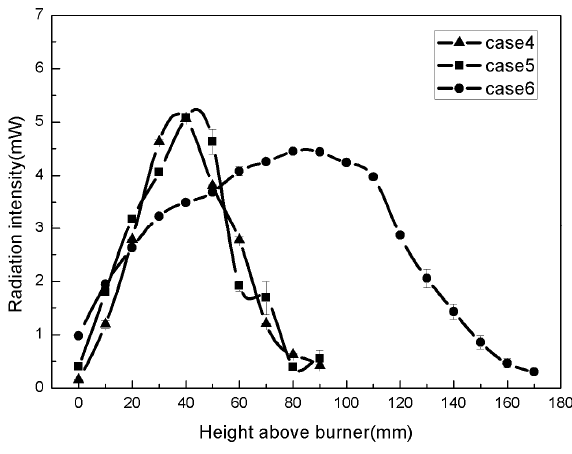
Figure 11. Radiation intensity at the centerline of three different flames.